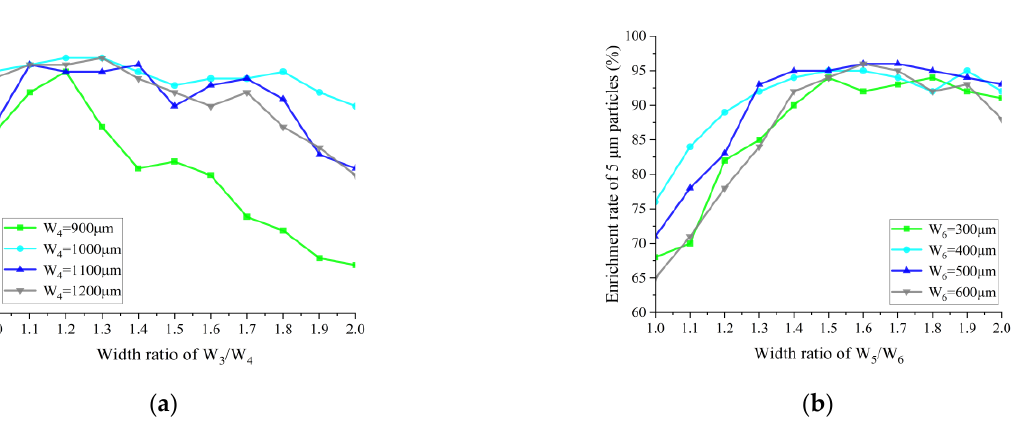
Figure 4. ( a ) Effect of W 3 /W 4 on the enrichment efficiency of 12 μm particles; ( b ) effect of W 5 /W 6 on the enrichment efficiency of 5 μm particles.